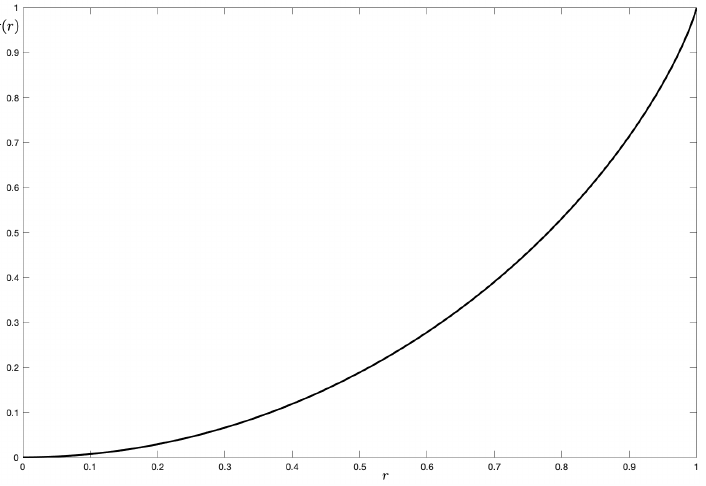
Figure 3. A proposal for the saturation of a quantum chromatic state from built from its von Neumann